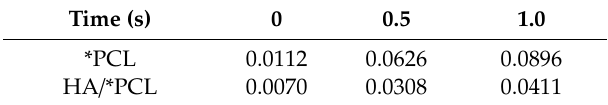
Table 2. Von Mises stress (Pa) on the sca ff old surfaces as calculated via Comsol multiphysics